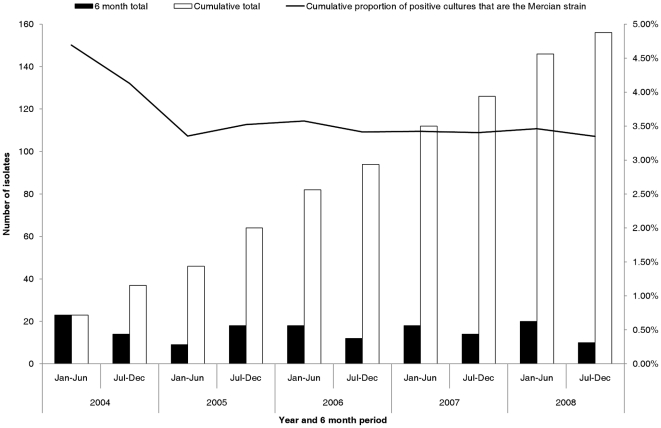
Incidence and cumulative total of the number of patients with the Mercian strain between 2004 and 2008.